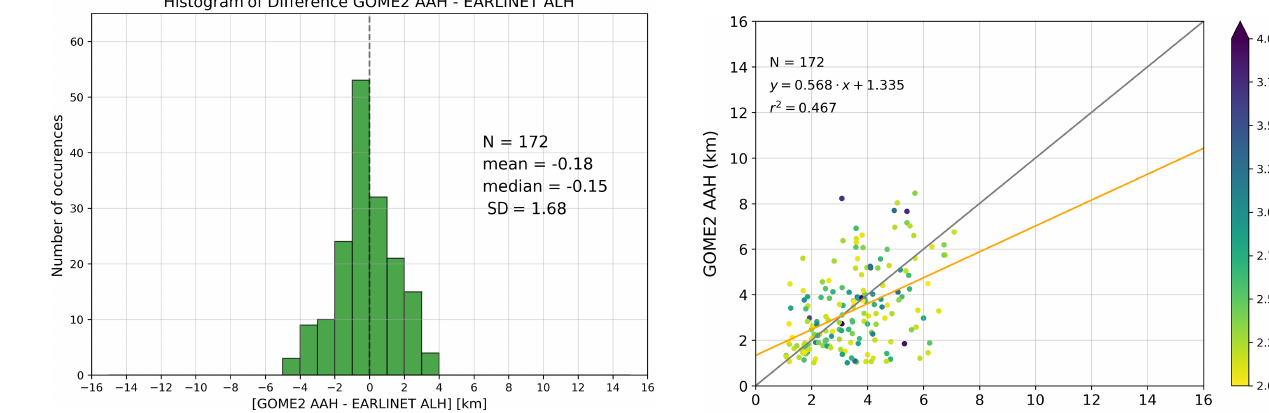
Figure 9. Scatterplot between GOME-2 AAH and aerosol layer height from EARLINET stations, for the total of collocated cases. The associated AAI value is colour